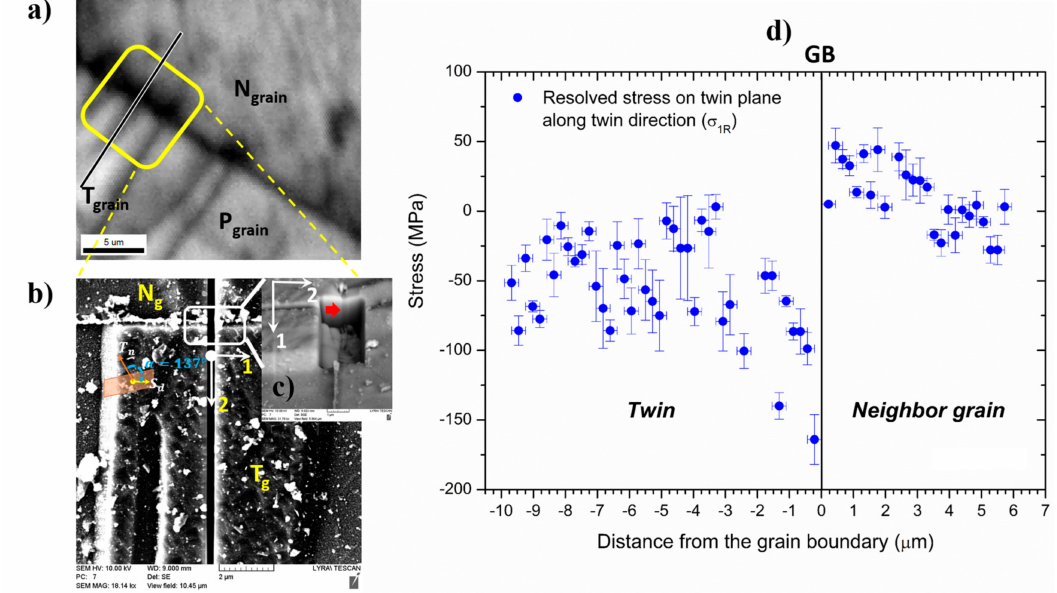
Figure 8. ( a ) Image quality map of region shown in Figure 7a with schematic of milled slit; ( b ) SEM image of decorated twin-grain boundary intersection from Figure 7a; twin boundary plane orientation is shown in orange with twin plane normal T n and twin shear direction S d . Slit coordinate system labelled by directions ‘1’ and ‘2’, measured angle between twin boundary normal and axis ‘1’ (normal to the slit wall) is displayed as 137 ◦ ; ( c ) the orientation of the grain boundary plane (marked by red arrow) with respect to the slit length aligned normal to the wall of the milled trench; ( d ) corresponding measured resolved shear stress component (along the twinning plane in the direction of twinning shear) along line